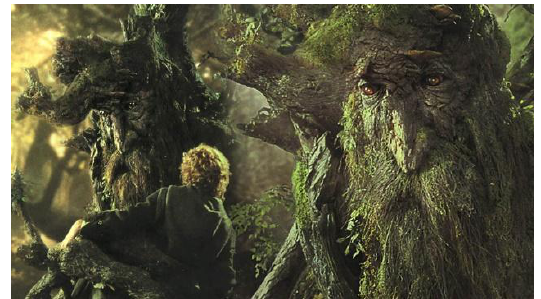
Fig. 2. The Ents - the talking trees in Lord of the Rings – were an inspiration during the ideation